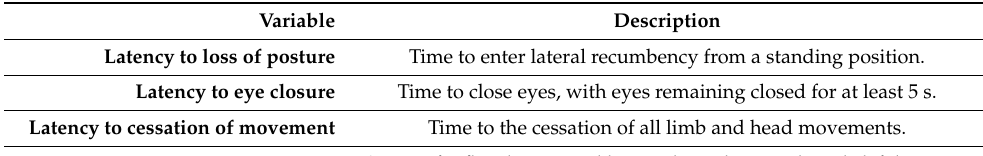
Figure 2. Inflation cuff applied to a piglet, secured around the thorax with velcro and prevented from slipping onto the abdomen by a soft fabric strap. A rectal thermometer is being inserted into the rectum, and a pulse oximetry electrode is attached to the ear.